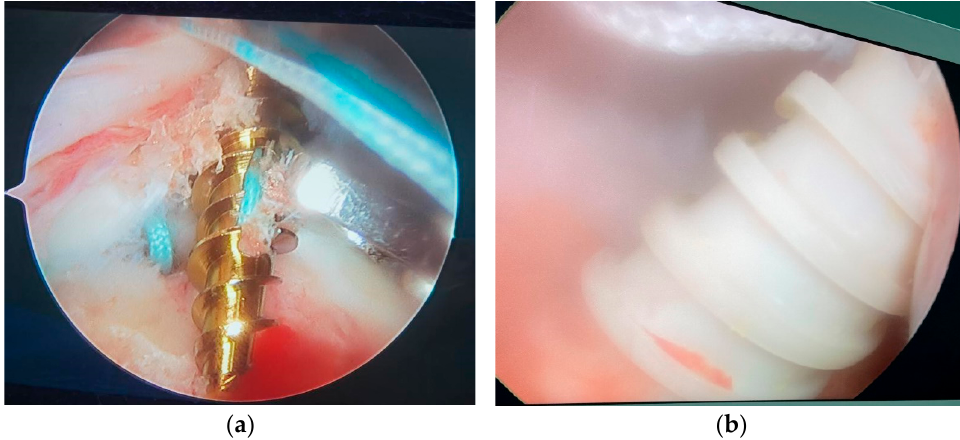
Figure 1. ( a ) Intraoperative metallic suture anchor pullout; ( b ) intraoperative polyetheretherketone suture anchor pullout.